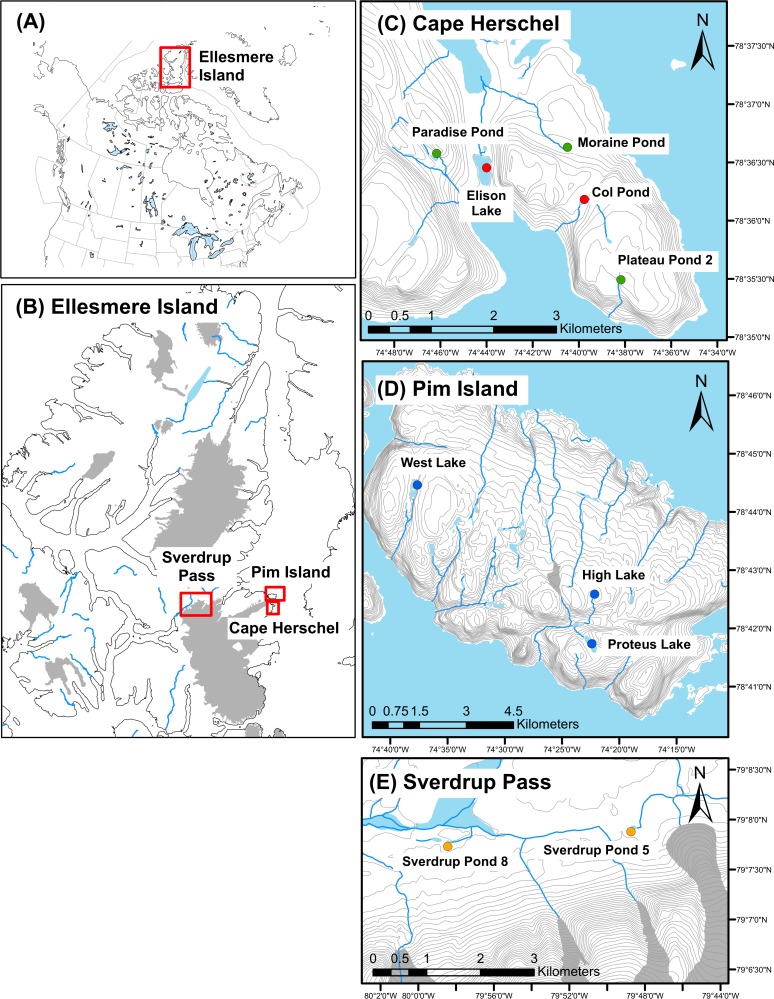
Location map of study sites.Location map for Ellesmere Island, Nunavut, Canada (A), with Ellesmere Island in detail highlighting the three study regions: Cape Herschel, Pim Island, and Sverdrup Pass (B), and higher resolution insets of Cape Herschel (C), Pim Island (D), and Sverdrup Pass (E) identifying the 10 lakes and ponds in this study with “warm” sites as red circles, “cool” sites as green circles, “cold” sites as dark blue circles, and “oasis” sites in orange. Major hydrological features are shown in light blue, glaciers in dark grey and 20 m topographic contours as light grey lines. Source: Natural Resources Canada [28].